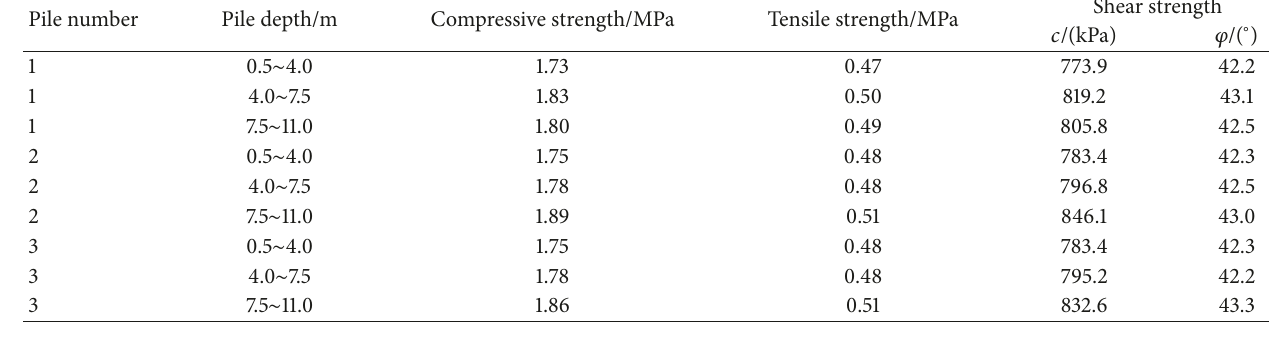
Table 10: Strength of core sample (90d).